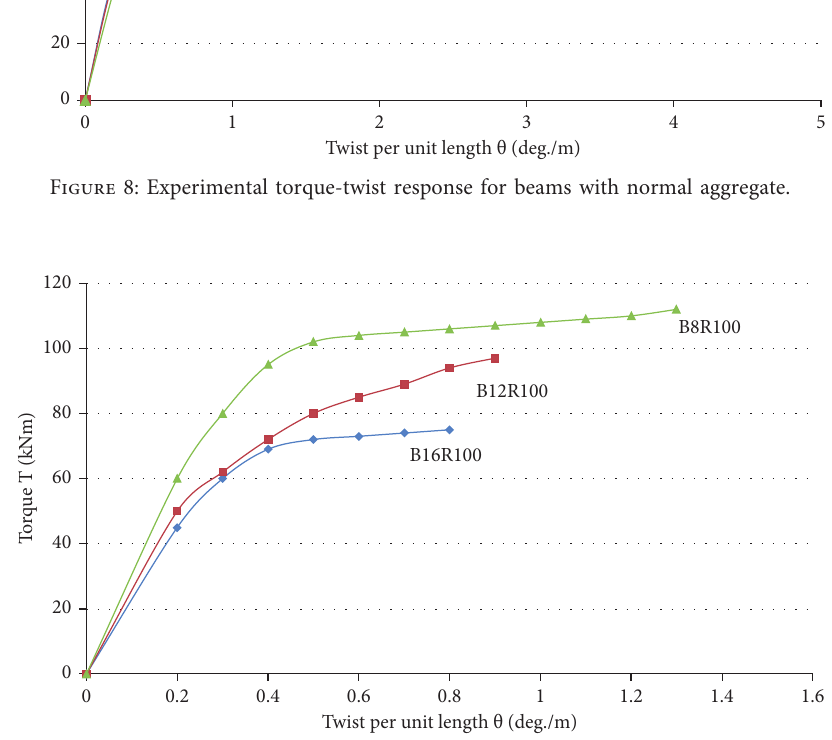
Figure 9: Experimental torque-twist response for beams with 100% recycled